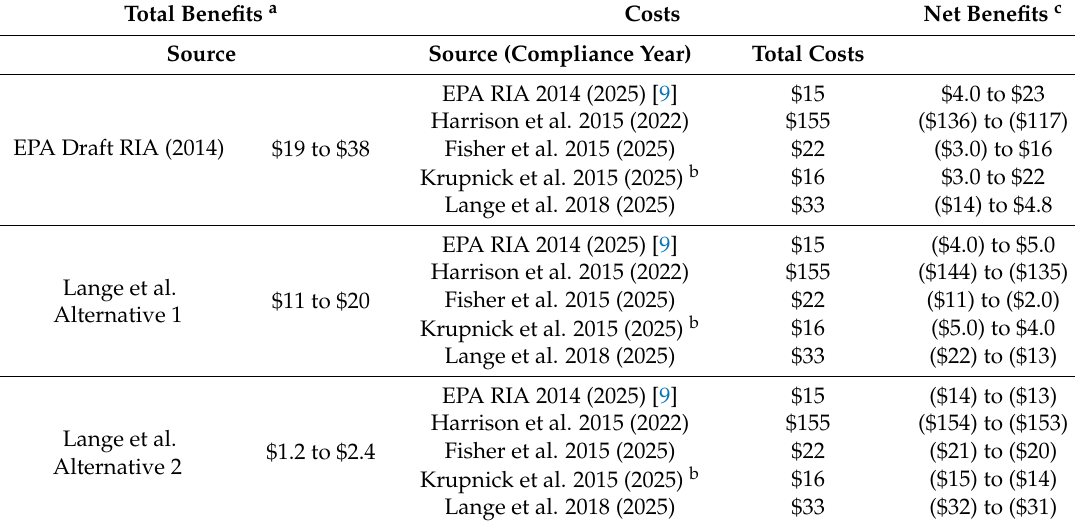
Table 5. Net Benefits Based on EPA’s Estimate of Monetized Ozone and PM 2.5 Net Benefits for Proposed Annual Ozone Standard of 0.065 ppm 2025 Scenario [9] (nationwide benefits of attaining each alternative standard everywhere in the U.S. except California and except as noted; compliance year in parentheses)—Full Attainment (billions of 2011$) a